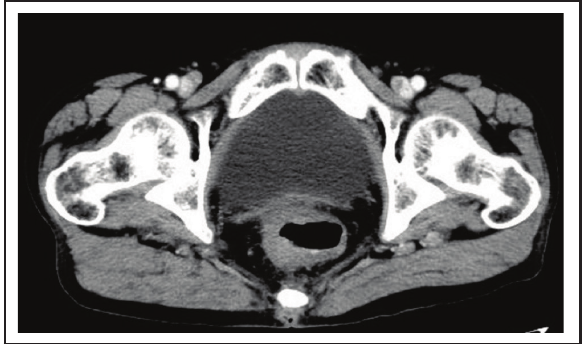
Figure 1. Contrast-enhanced computed tomography of the abdomen (axial section) shows asymmetric thickening of the wall of the rectum; no perirectal lymph nodes are